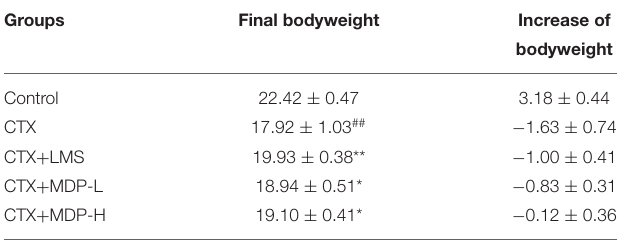
TABLE 3 | Effect of MDP on the body weight in mice induced by CTX.